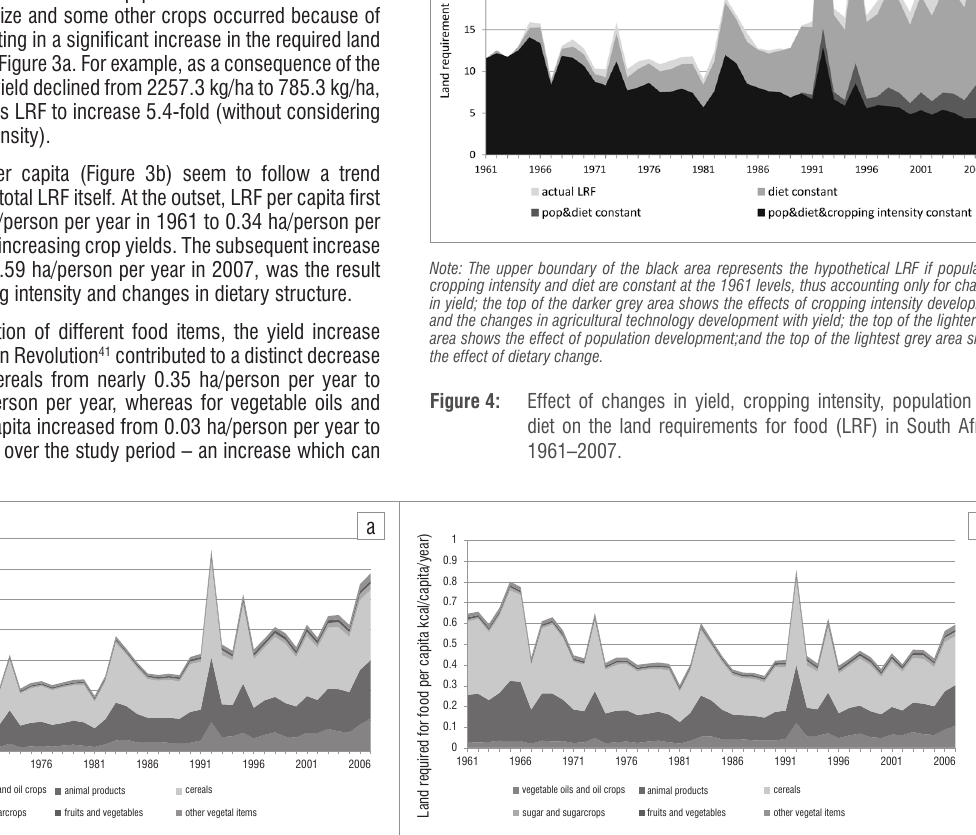
Figure 3: Land requirements for food in South Africa from 1961 to 2007: (a) total and (b) per